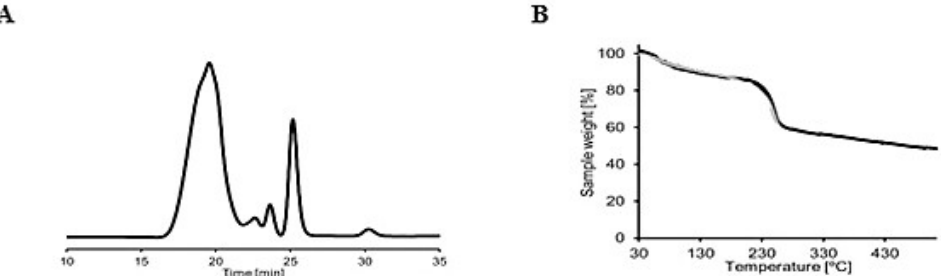
Figure 2. ( A ) RI signal of size exclusion chromatography with multiple angle laser light scattering (SEC-MALLS) analysis and ( B ) thermogravimetric analysis (TGA) of sodium alginate.